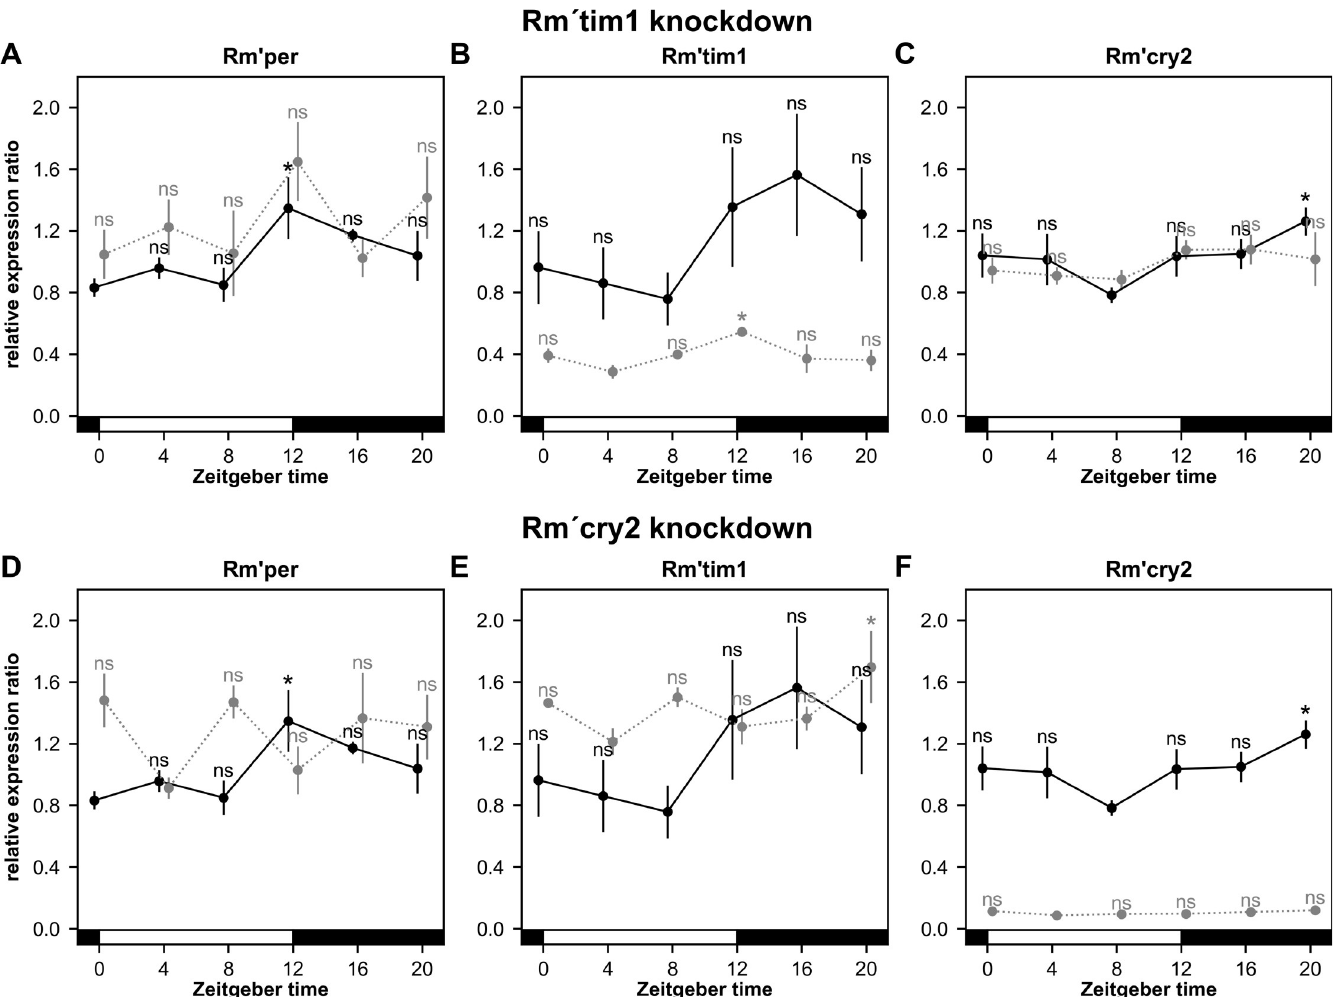
Fig 9. A-F. Except for Rm´tim1 both, dsRNA-dependent downregulation of Rm´tim1 (A-C) or of Rm´cry2 (D-F) abolished cycling of mRNA levels of both other circadian clock genes examined. Solid lines represent control animals, dotted lines Rm´tim1 ( A-C ) or Rm´cry2 ( D-F ) dsRNA injected animals respectively. Relative expression ratios are analyzed compared to the lowest value of the respective curve. Relative expression ratios of Rm´per ( A ), and Rm´cry2 ( C ),but not Rm´tim1 ( B ) cycled ZT-dependently in controls (n = 3 per Zeitgeber time (ZT) in each group).Minima in mRNA levels of the controls are at ZT 0 ( Rm´per ) and at ZT 8 ( Rm´tim1 , Rm´cry2 ). Expression maxima in controls occurred at the beginning of the night (ZT 12; Rm´per ), the middle of the night (ZT 16; Rm´tim1 ), or the end of the night (ZT 20; Rm´cry2 ).Successful knockdown of Rm´tim1 to ~40% of WT mRNA levels deleted rhythmic expression of Rm´per ( A ) and Rm´cry2 ( C ), but not of Rm´tim1 ( B ). Knockdown of Rm´cry2 to ~10% of WT levels deleted rhythmic expression of Rm´per ( D ) and Rm´cry2 ( F ), but not of Rm´tim1 ( E ). Whole brains of cockroaches at different ZTs in 12:12 LD cycles were collected for qPCR experiments. The bars at the bottom of the plots indicate light (white) and dark (black) phases. A linear mixed model was used to determine significant differences within groups. The ZT with the lowest data points within each curve was always compared with all other ZTs of the curve. Error bars represent standard errors. ns = not significant; � : p < 0.05.